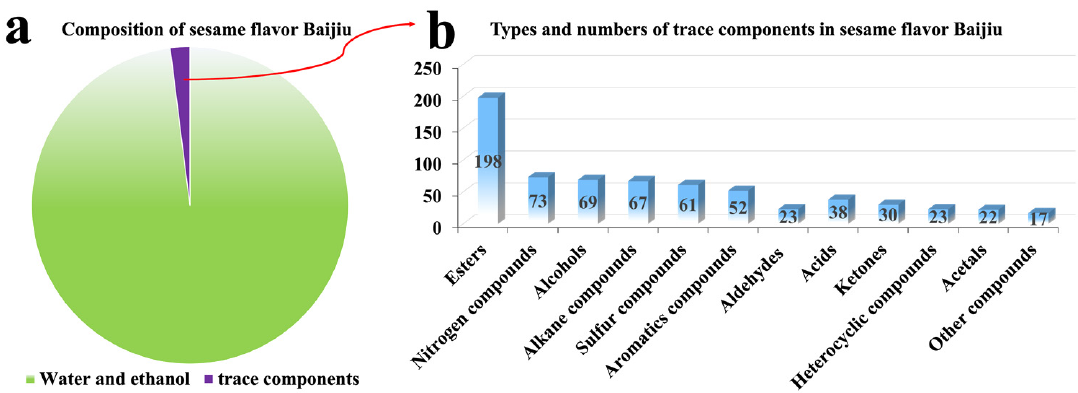
Figure 3. Types and numbers of trace components in sesame flavor Baijiu.